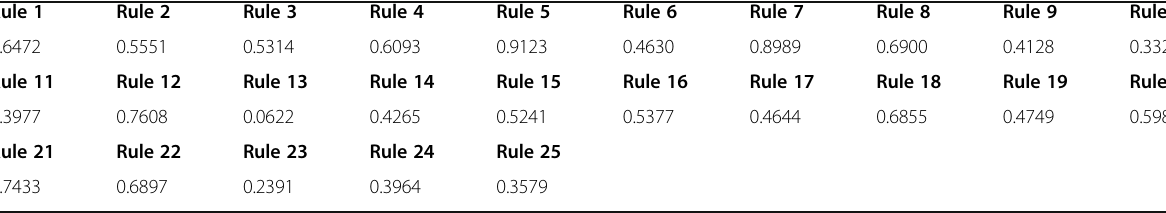
Table 8 Rule weights of the proposed adaptive FO-fuzzy